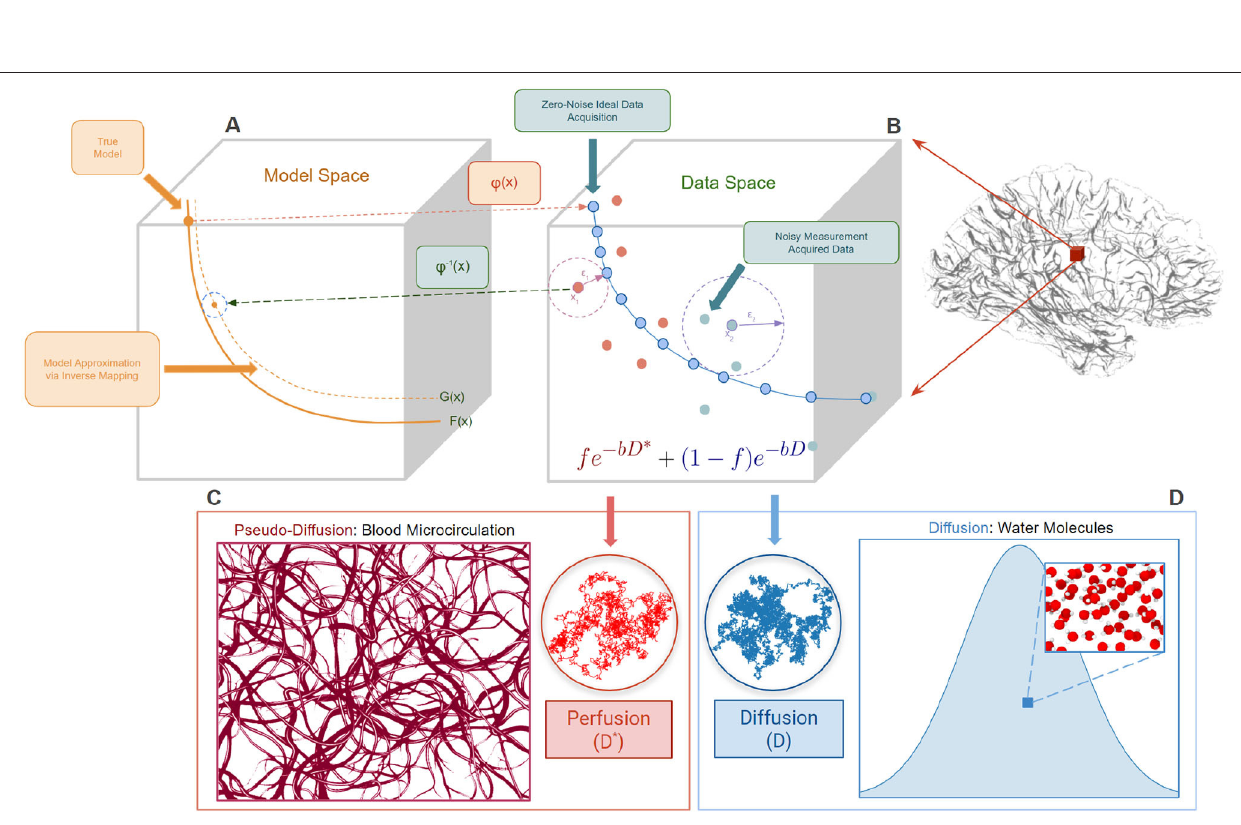
FIGURE 2 | The above figure demonstrates the levels of optimization involved in TopoPro. (A: Level-1) Depicts the steps involved in solving the reduced functional and estimating the parameters. The reduced functional of only the non-linear parameters has been visualized with the simplicial homology corresponding to its objective function. (B: Level-2) Shows the valley function formed in the process of optimizing the full-functional in the second level. It delineates a problem of bi-modality where the points corresponding to different minima have been indicated in red color.